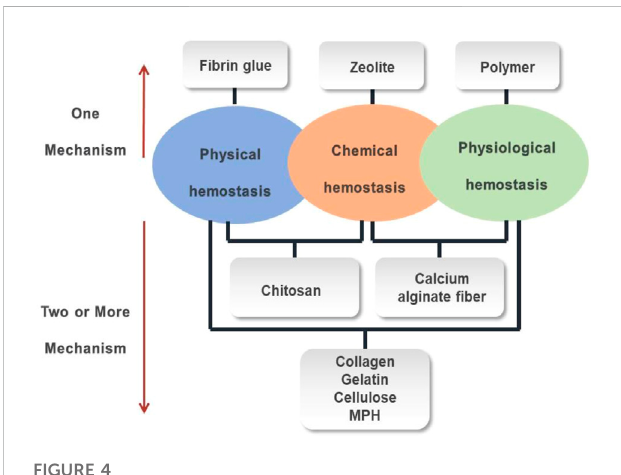
FIGURE 4 The hemostatic biomaterials with different